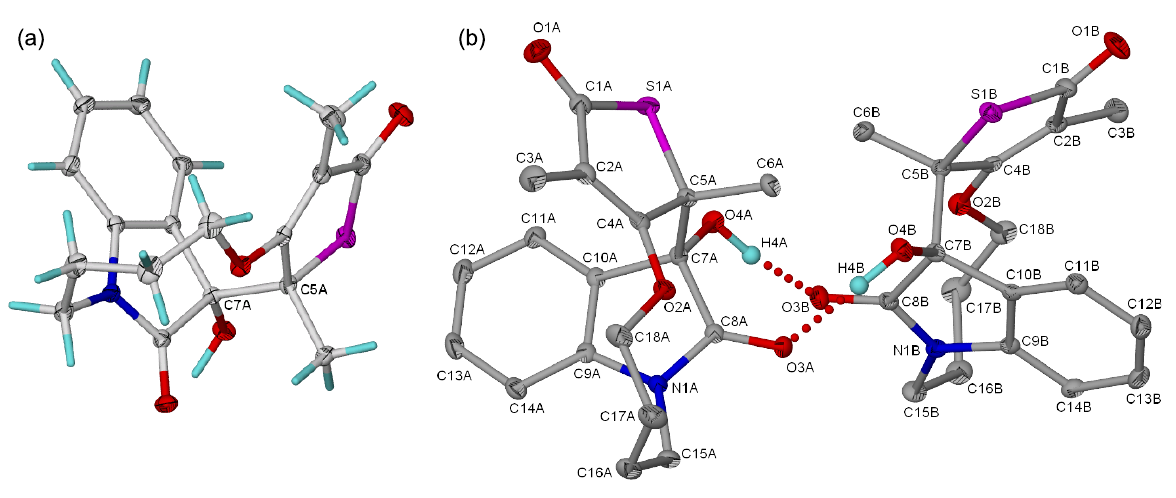
Figure 3: (a) Molecular structure of the tetracycle 4a . (b) Structure of the dimer of 4a showing the atomic numbering scheme. Displacement ellipsoids are drawn at 40% probability level for non-hydrogen atoms. All hydrogen atoms are omitted except the hydroxyl hydrogens.